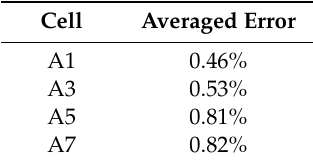
Table 6. Average error during charge estimation of Li-ion batteries’ charge at di ff erent cycles using cycle number higher than 250.